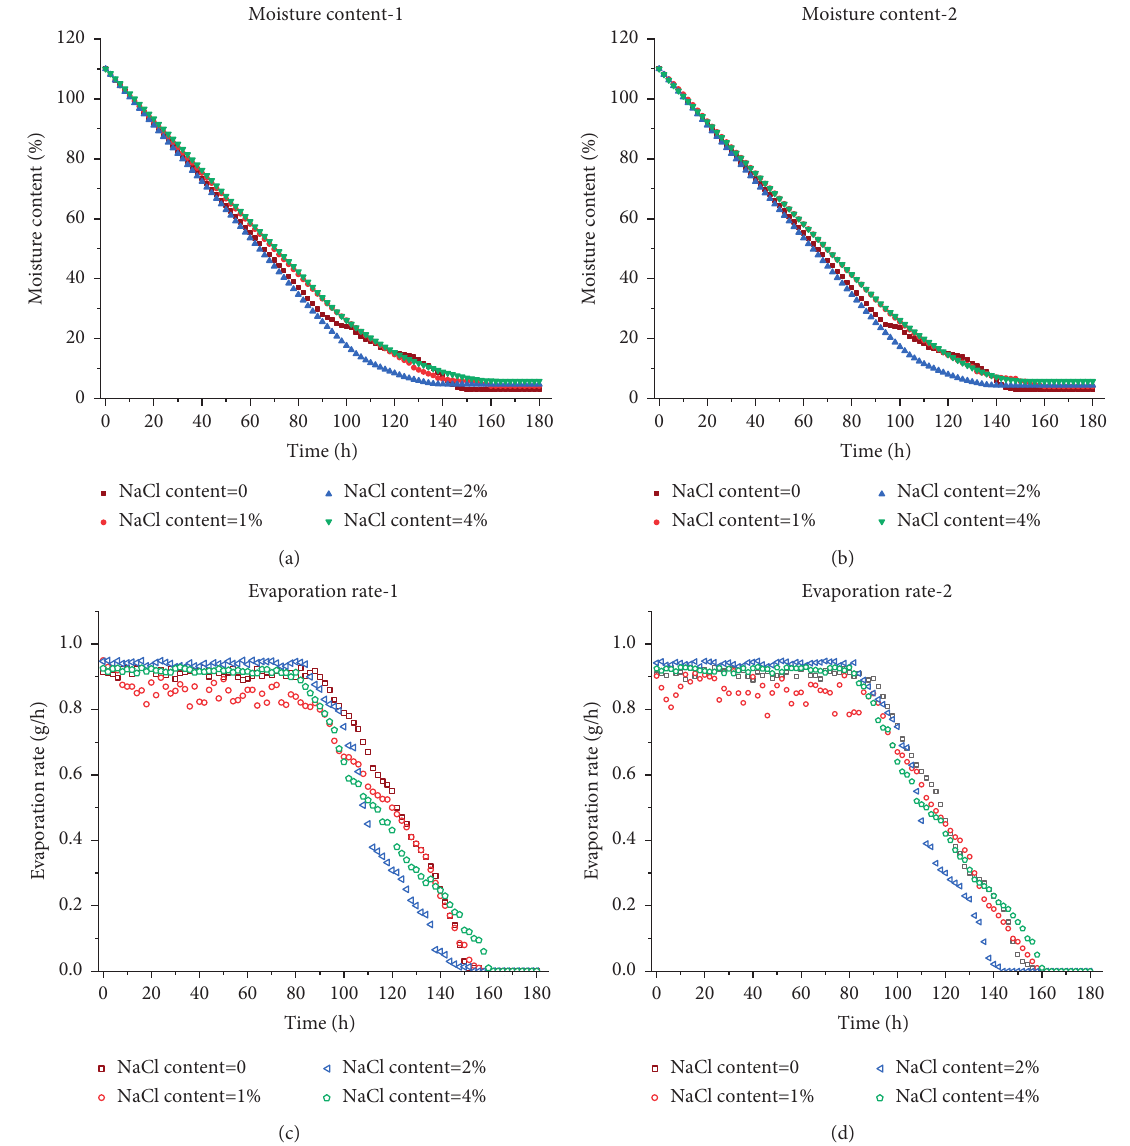
Figure 4: Rate of evaporation versus time. (a) Water content versus salt concentration. (b) Water content versus salt concentration of the second set of samples. (c) Rate of evaporation of samples with time for different salt concentrations. (d) Evaporation rate of samples with time for different salt concentrations of the second set of